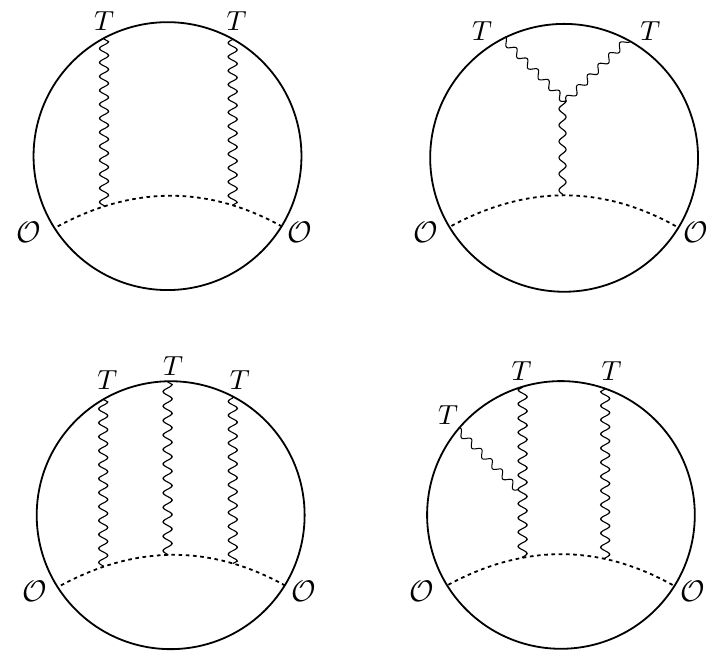
Figure 3 . Examples of tree-level diagrams for the hOO [ T m ] i OPE coefficients in the case of a minimally-coupled scalar. The left two diagrams contribute to the minimal-twist [ T m ] OPE data, whereas the right two diagrams do